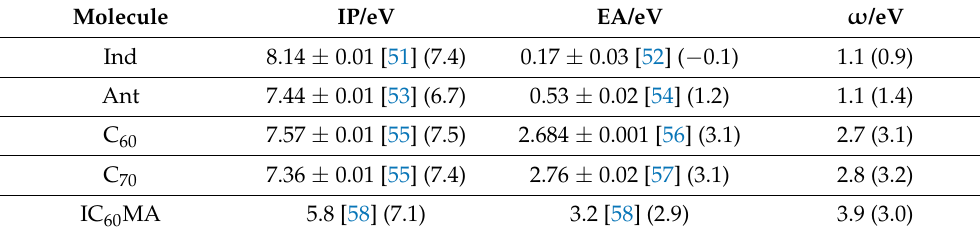
Table 5. Reported literature values of ionization potential, IP, and electron affinities, EA, in the gas phase for the selected reactants and calculated electrophilicity index, ω . The values obtained from the HOMO and LUMO energies calculated in this work using M06-2X/6-31+G(d) are shown in parenthesis 1